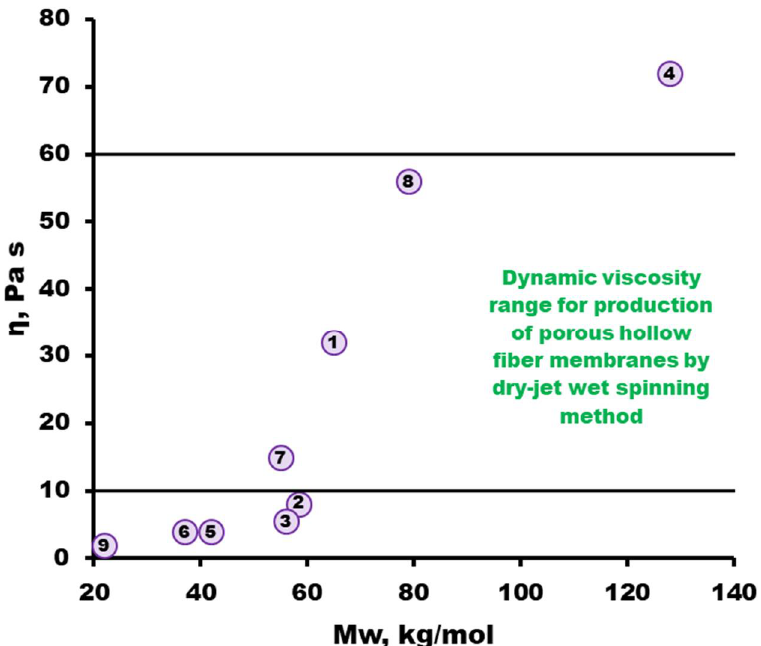
Figure 6. Dependence of the dynamic viscosity of the PSF/NMP/PEG-400 (21/49/30 wt.%) dope solutions on the molecular weight of the polymer. The sample numbers are the same as those in Table 3.